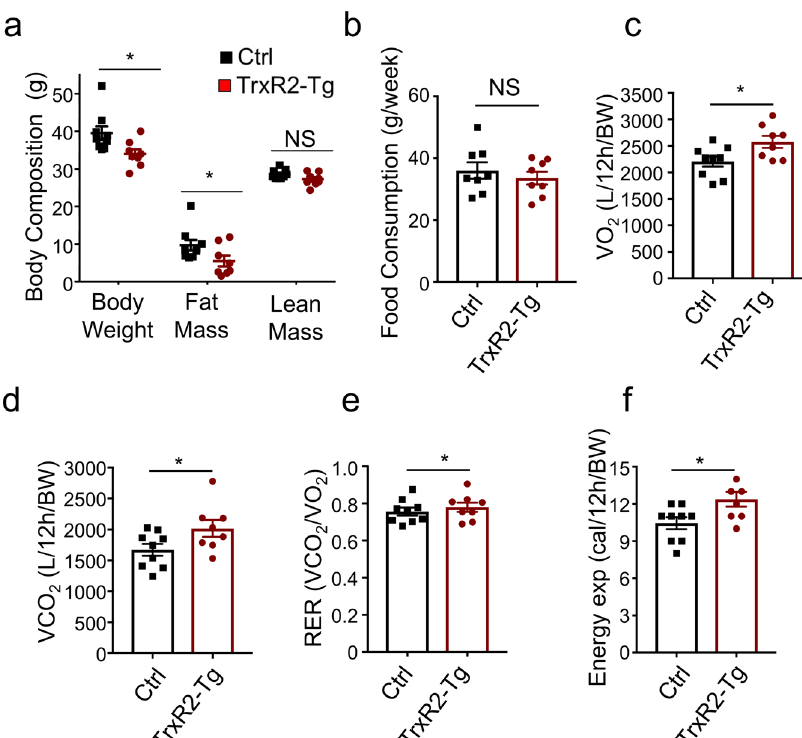
Fig. 3 TrxR2 overexpression increases light cycle whole-body metabolism in the normal diet-fed male mice. a TrxR2-TG male mice are leaner with lower weight and fat mass relative to littermate controls as measured by qMRI (see methods, n = 8 – 9). b Food consumption is unaltered. Food intake was recorded for 7 days, ( n = 8 – 9). c – f Indirect calorimetry was performed in normal-fed male mice. Parameters for each mouse were obtained and normalized by body weight. c Daytime O 2 consumption (VO 2 ). d CO 2 production (VCO 2 ). e RER (CO 2 /O 2 ), and f energy expenditure (Heat). All experiments utilized 8 months old normal-fed male mice, n = 8 – 9. Values are Mean ± SEM. * p <